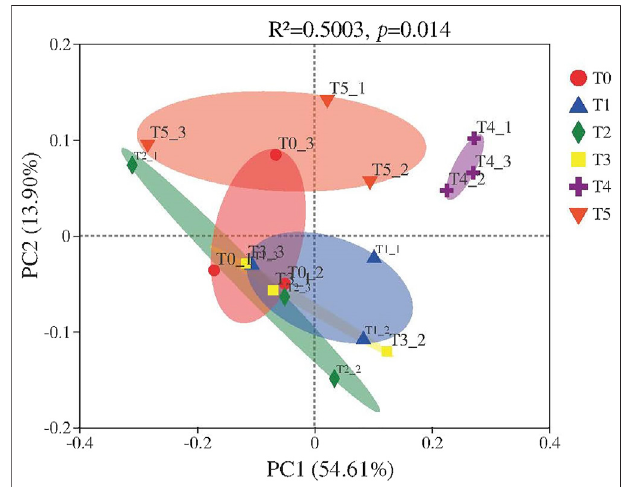
FIGURE 3 | Analysis of bacterial community composition in six different treatments in swine manure